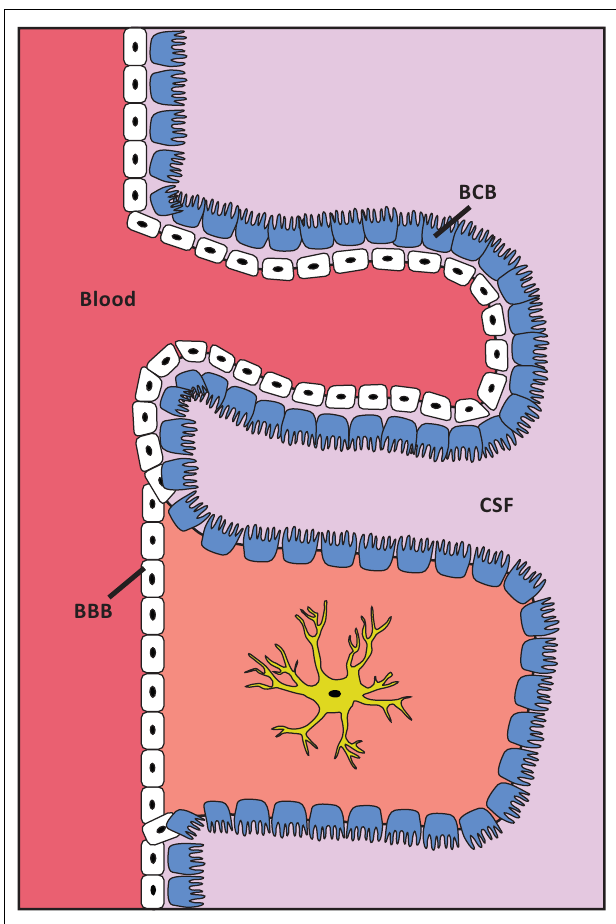
FIGURE 1 | Schematic presentation of the localization of the BBB and the BCB. White cells are capillary endothelial cells. Blue cells are ependymal cells.The structure of cell layers in the choroid plexus/BCB is shown in the top of the figure.The structure of cell layers elsewhere in the brain/BBB is shown in the lower part of the figure.The capillary endothelial cells are tightly bound by tight junctions, except at the choroid plexus. In the choroid plexus the ependymal cells are, in contrast to elsewhere in the brain, tightly bound by tight